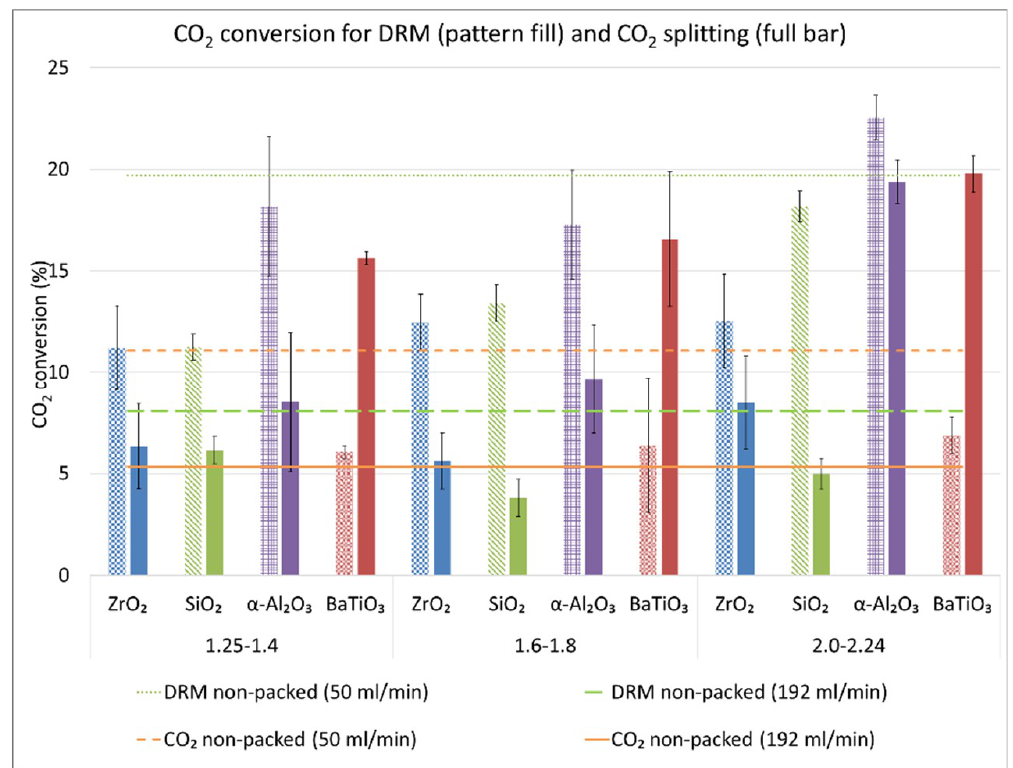
Figure 1. CO 2 conversion for different sphere sizes and materials, compared to the results for the non-packed reactor, at the same flow rate (50 mL/min) and at the same residence time (5.52 s; flow rate of 192 mL/min), all at 23 kHz frequency, in a 4.5 mm gap and a set 100 Watt power for both DRM (dry reforming of methane) and pure CO 2 splitting. The bars with pattern fill show the results for DRM, whereas the full bars show the correct results for CO 2 splitting, obtained from our previous work